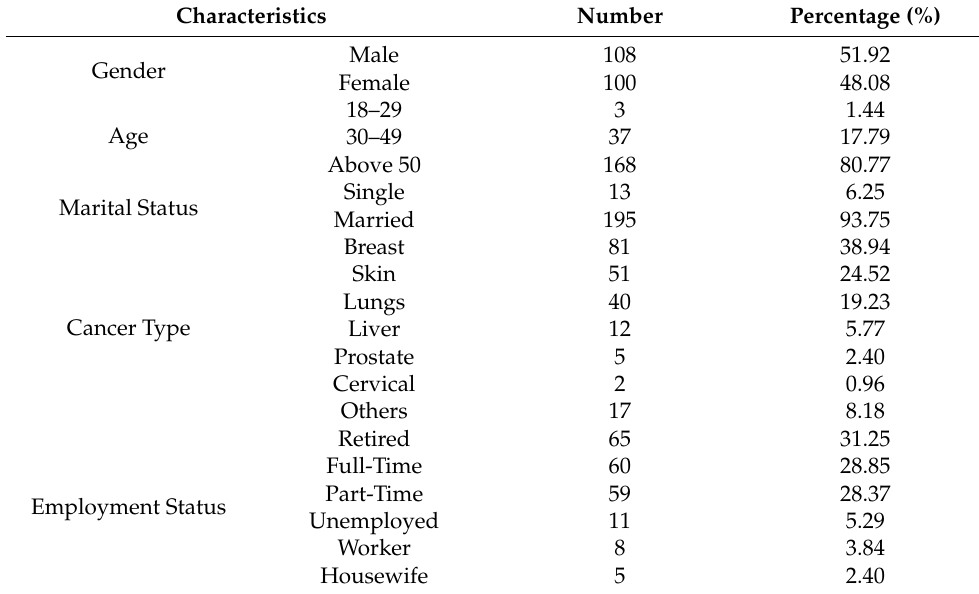
Table 1. Demographic characteristics of participants (N = 208).